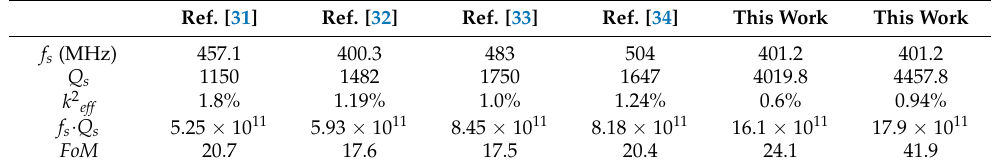
Table 3. The key performance parameters of the fabricated resonators, and compared with previous ones.